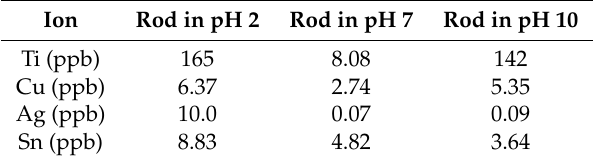
Table 4. ICP-MS analyses of solution containing submerged Ti rods at pH 2, 7, and